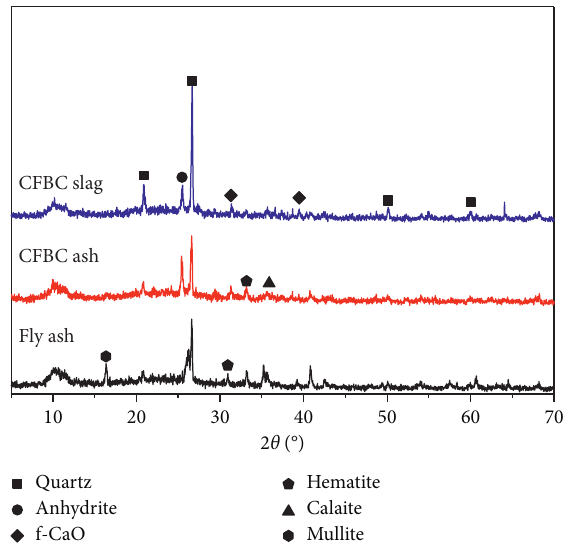
Figure 2: XRD patterns of fly ash, CFBC ash, and CFBC slag.